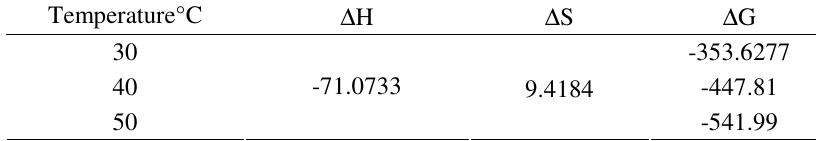
Figure 9. Temkin plot-temperature variation Table 4. Thermodynamic